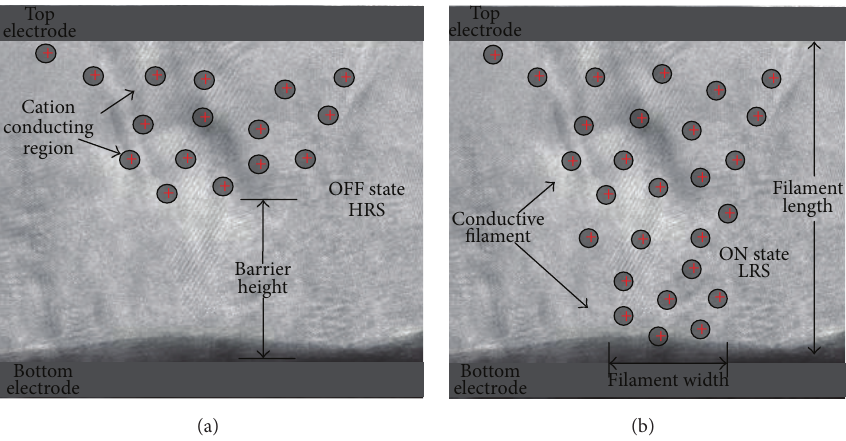
Figure 1: The ReRAM on/off switch is first formed in the media films after a virgin voltage bias. The thin filaments rupture in the reset process and the current is hard to flow between TE (top electrode) and BE (bottom electrode), and the ReRAM shows HRS (high resistance state) characteristics. The thin filaments reconduct under the electric field in the set process. The current is easily flowing through TE and BE, and the ReRAM exhibits LRS (low resistance state). (a) No filament exists in the initial state. (b) Filament is formed by ion